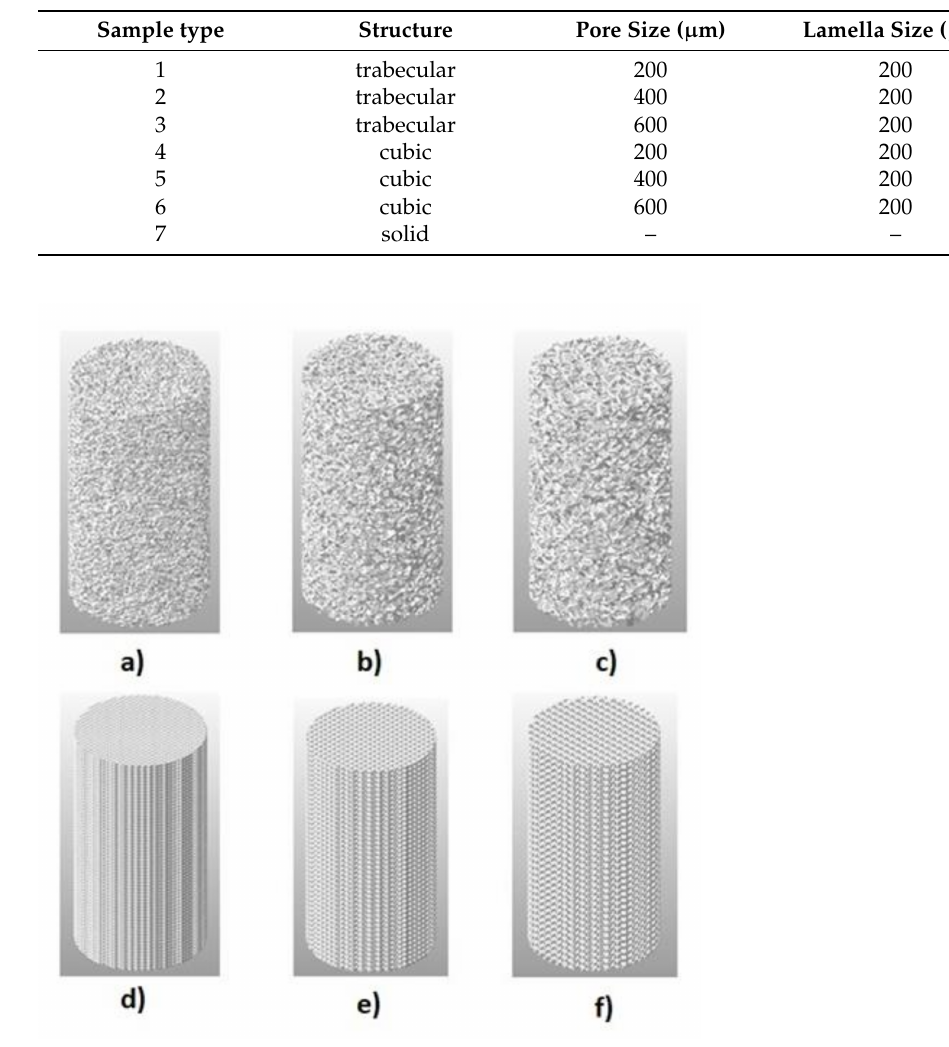
Figure 2. 3D CAD models of porous samples: ( a ) trabecular with 200 µ m pore size, ( b ) trabecular with 400 µ m pore size, ( c ) trabecular with 600 µ m pore size, ( d ) cubic with 200 µ m pore size, ( e ) cubic with 400 µ m pore size, ( f ) cubic with 600 µ m pore size.